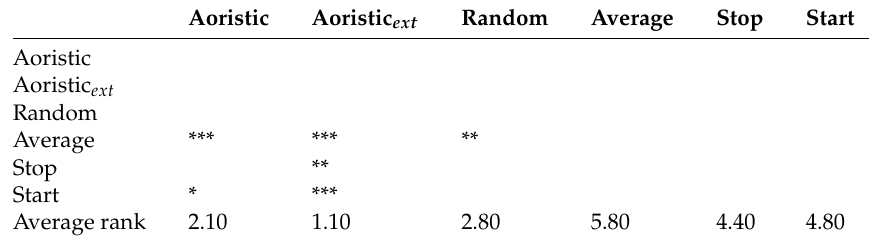
Table 13. Nemenyi significance test results from pair-wise comparisons between temporal analysis methods in the temporal resolution of day in year and with reduced numbers of crimes available during analysis. Aoristic Aoristic ext Random Average Stop